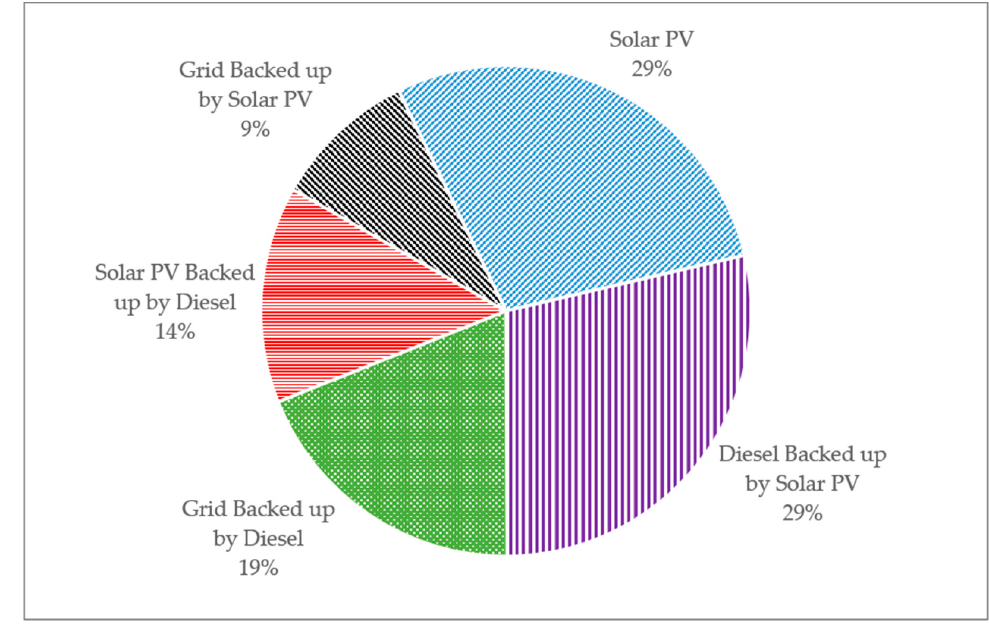
Figure 4. Source of electricity for HCFs with reliable electricity access.